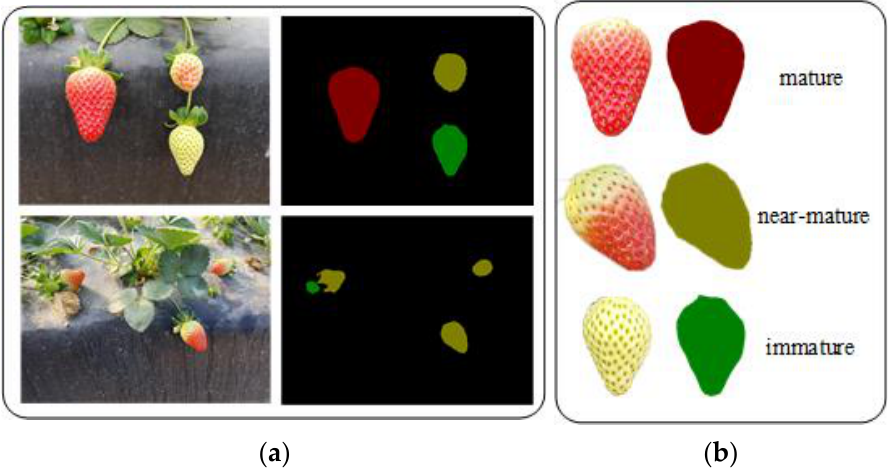
Figure 3. Labeled sample data set. ( a ) Strawberry image dataset and labeled images; ( b ) strawberry mask images.